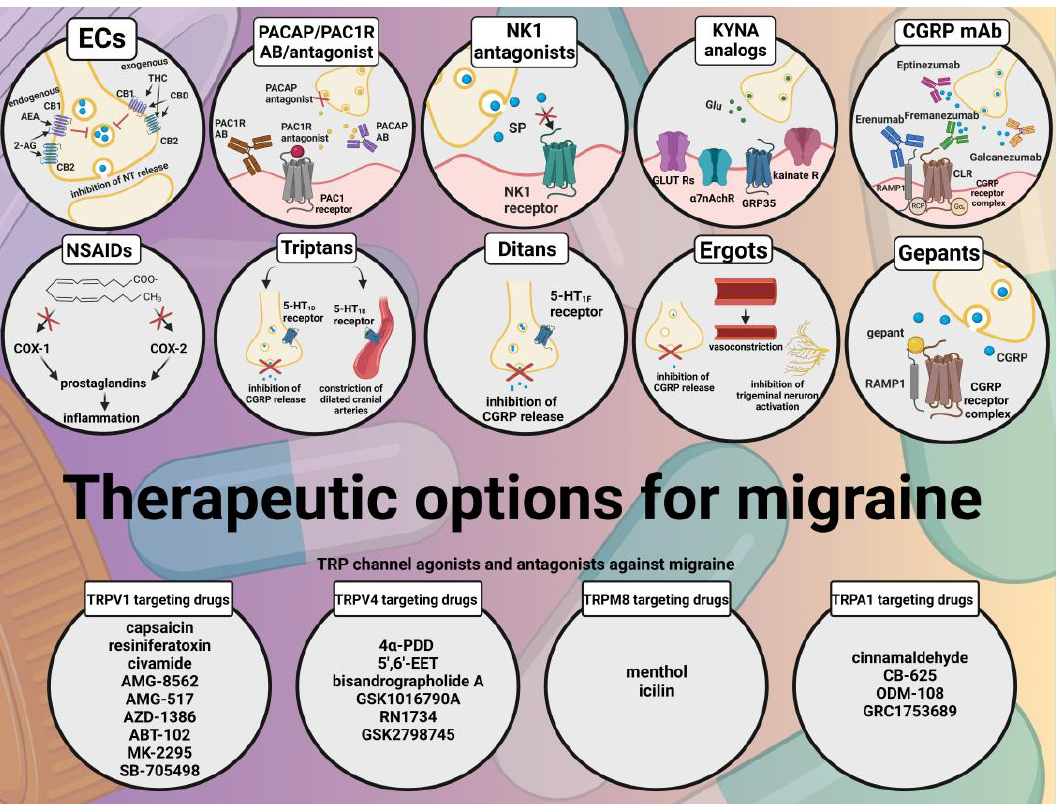
Figure 7. Summary of current and emerging therapeutic options for migraine. Several medications have been designed to treat migraines. Classes of medications used for acute treatment of migraine include simple analgesics such as NSAIDs; migraine-specific treatments, such as serotonin receptor agonists (triptans, ditans); and ergot derivatives. In addition to these, treatments that inhibit the release of CGRP are also receiving increasing attention: small molecule CGRP receptor antagonists and monoclonal antibodies. Future therapies include targeting additional molecules involved in the pathomechanism of migraine, such as PACAP, ECs, and NK1. Furthermore, molecules targeting the kynurenine system are also at the center of attention in migraine therapy research. As TRP channels have been repeatedly implicated in the disorder, including TRPV1, TRPV4, TRPM8, and TRPA1, modulation of these receptors may provide future therapeutic options for migraine sufferers. Red cross means inhibition.